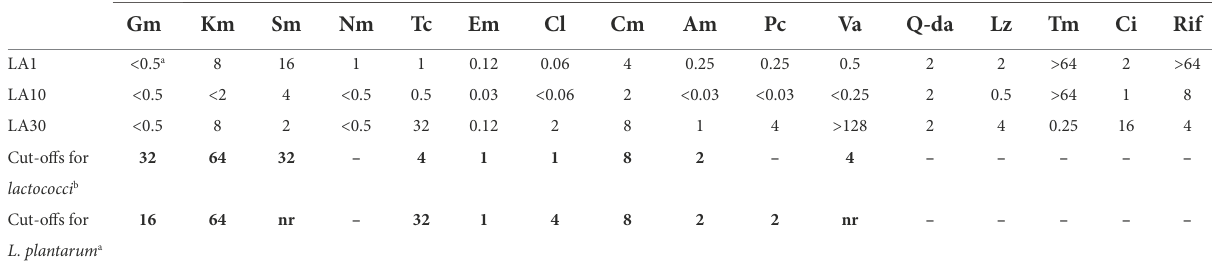
TABLE 3 Minimum inhibitory concentration of 16 antibiotics to L. lactis subsp. lactis LA1, L. cremoris subsp. cremoris LA10, and L. plantarum LA30.